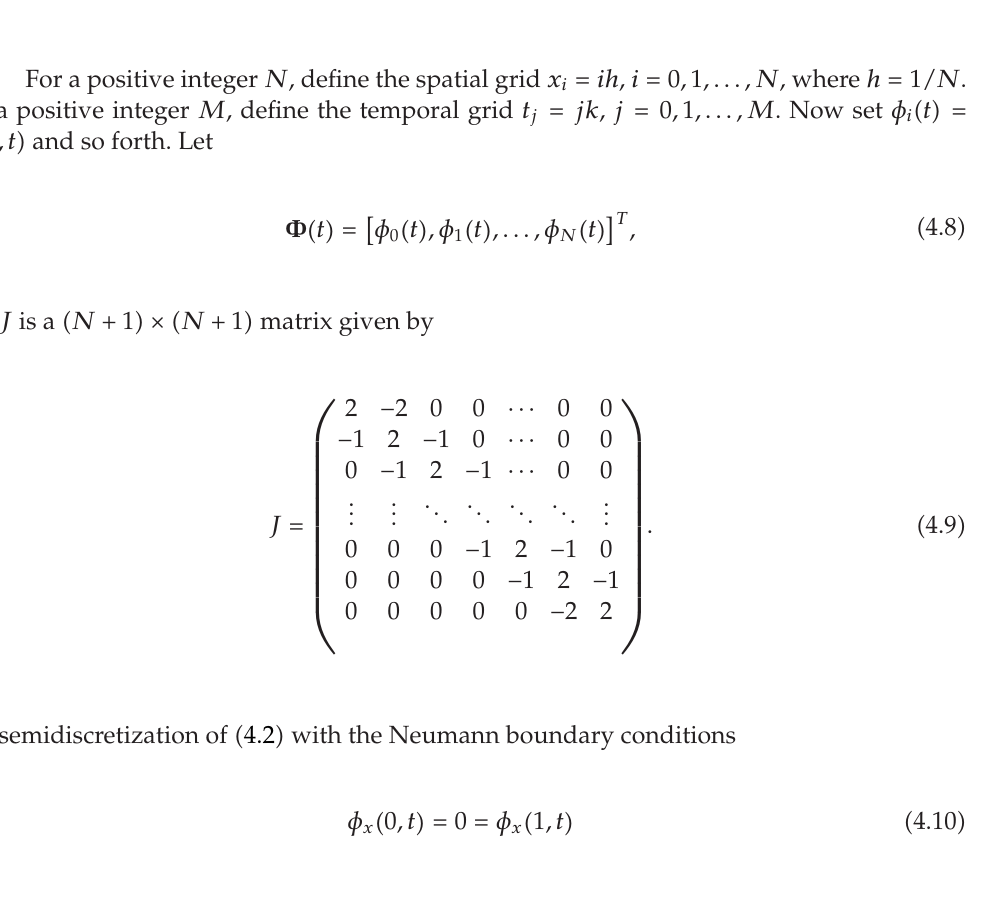
For a positive integer N , define the spatial grid x i (cid:8) ih , i (cid:8) 0 , 1 , . . . , N , where h (cid:8) 1 /N . For a positive integer M , define the temporal grid t j (cid:8) jk , j (cid:8) 0 , 1 , . . . , M . Now set φ i (cid:2) t (cid:3)